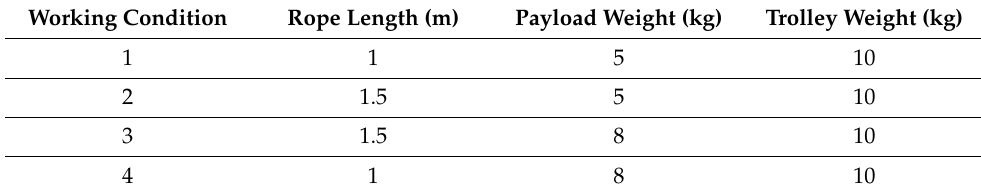
Table 9. Parameters of the crane under four working